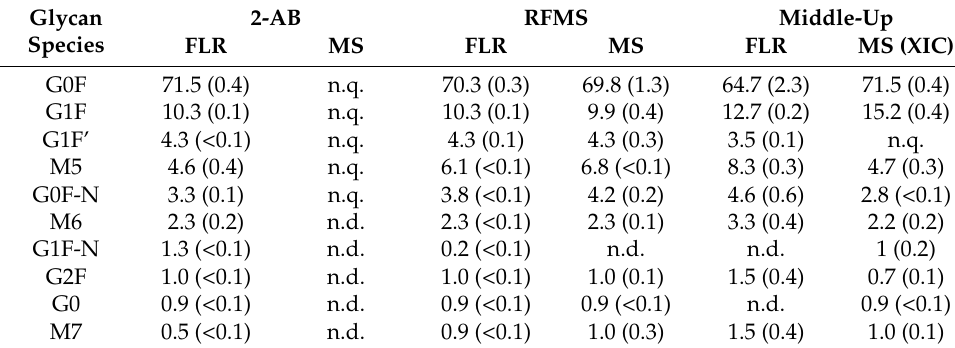
Table 1. Comparison of relative N- glycan abundance levels of adalimumab. Relative abundance levels were calculated for 2-AB and RFMS labelled N- glycans by integration of FLD and MS detection profiles. For middle-up level analysis, integration of FLD detection profiles and integration of extracted ion chromatograms (XIC) was used for quantitation. Relative abundance levels were displayed in percentage with the standard deviations in parentheses ( n = 3). G1F corresponds to galactosylation on the 6-branch and G1F’ to the galactose attached on the 3-branch of the glycan structure. n.d., not detected. n.q., not quantified. For the MS (XIC) column, quantitation of the G1F isomers separately was not possible due to their identical